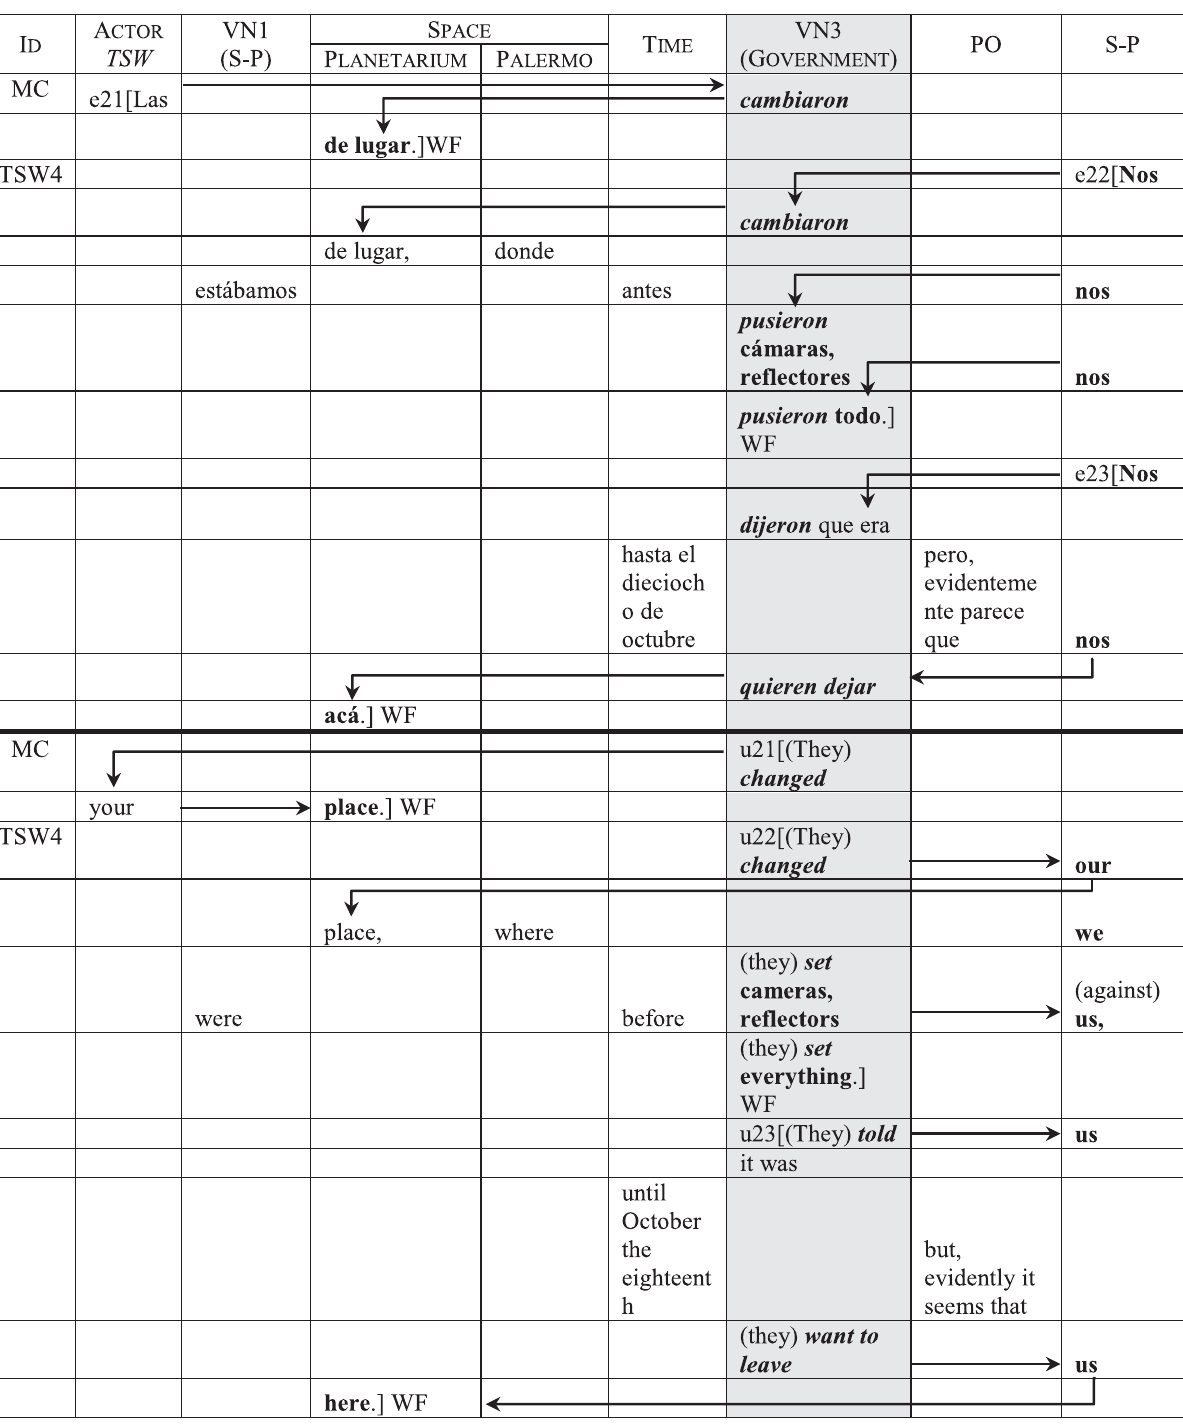
TABLE 9 | The representation of the Government of the City of Buenos Aires.